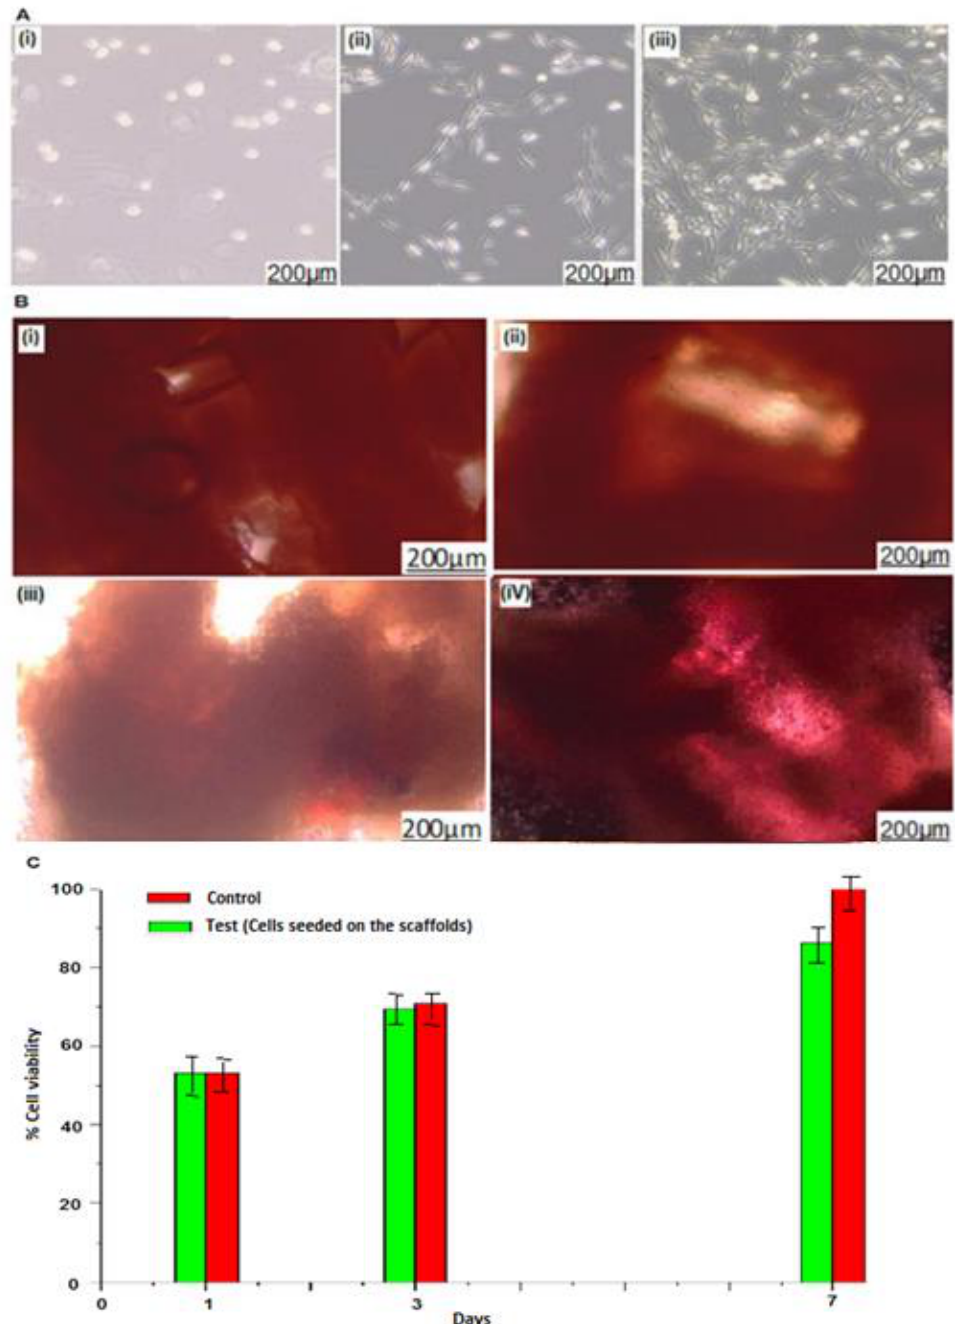
Figure 3. Images for ( A ) assessment of osteoblast-like MG63 cell differentiation on different days, where (i) depicts day zero, (ii) depicts day 2, and (iii) depicts day 3, ( B ) cell – scaffolds in different time intervals, where (i) depicts day zero (scaffold without cells as reference), (ii) depicts day 1 (cell-scaffold), (iii) depicts day 3 (cell-Scaffold) and (iv) depicts day 7 (cell-scaffold), and ( C ) cell viability performed on the 3D cell – scaffold within seven days using light microscopy (LC micro image analysis software).